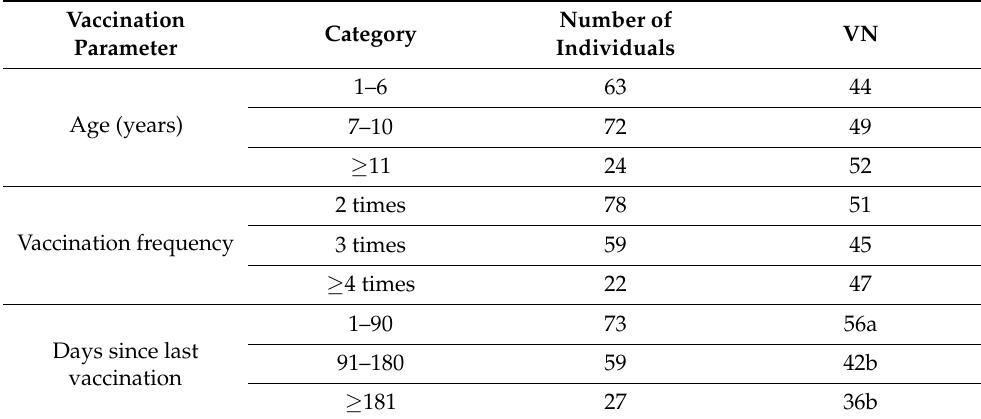
Table 3. Mean comparison of VNT dependent on the age, vaccination frequency, and the time since the last vaccination for the EHV-1 and EHV-4